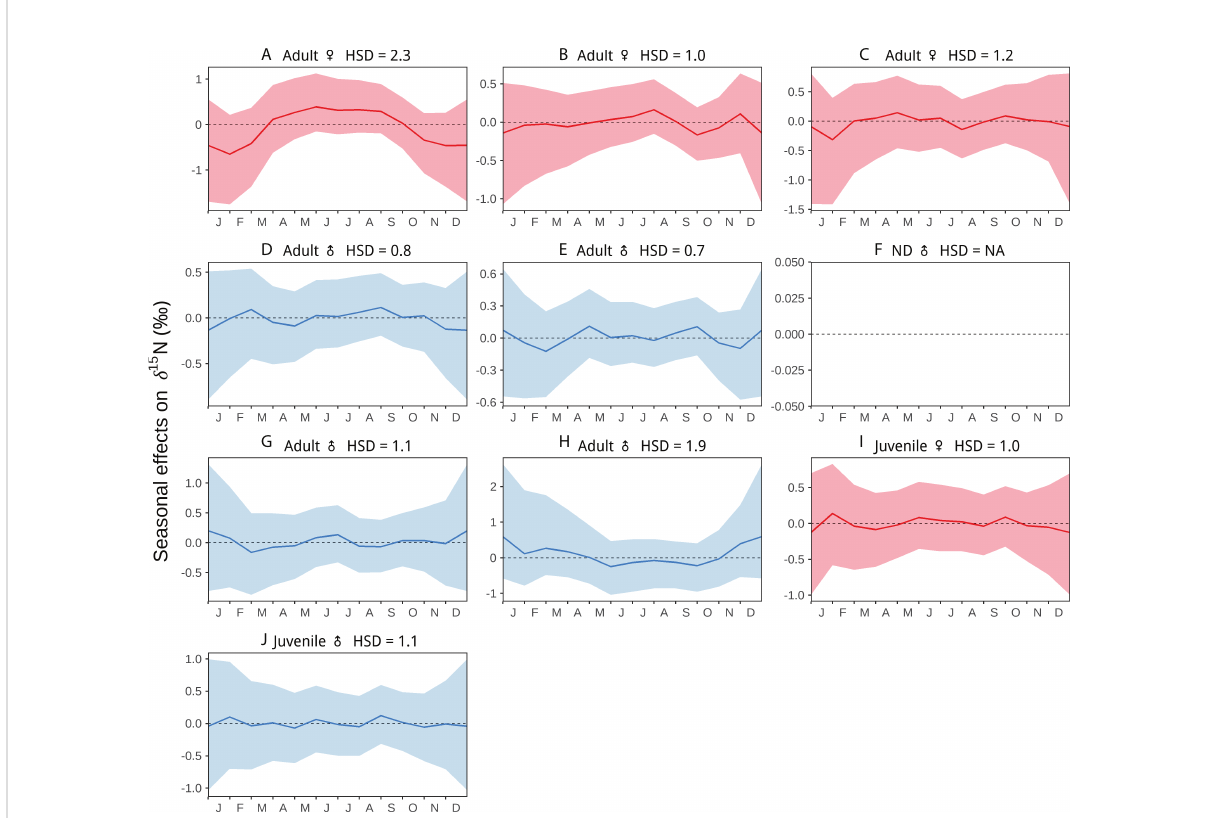
FIGURE 3 Seasonal random effects on d 15 N values along nine individual blue whale baleen plates as a function of time. The hyper-standard deviation (HSD) of the random-effect likelihoods is reported for each whale. Colors represent females (red), and males (blue). Colored dots and lines are the medians of the random effects, and colored shaded areas are the 95%-credible intervals. Figure shows whales (A – J) . This analysis was not possible for whale (F) given the lack of information on stranding